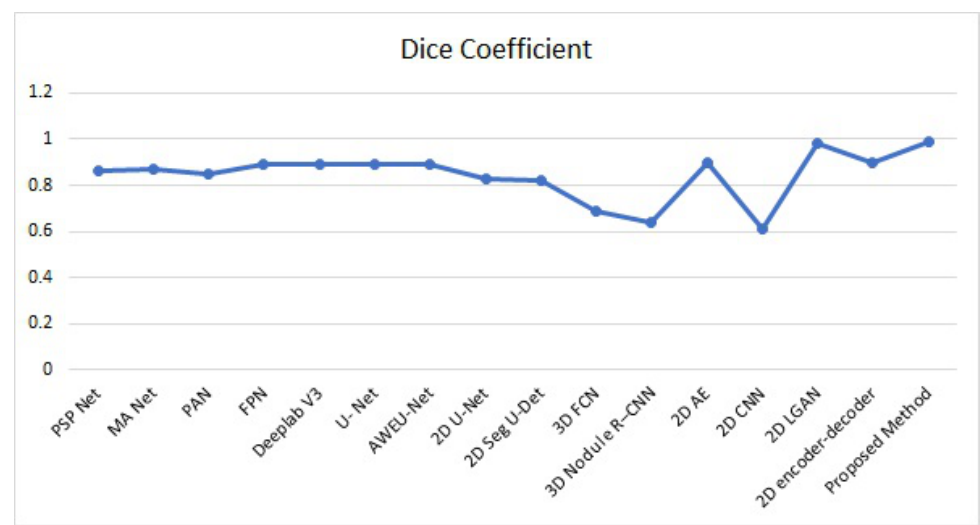
Figure 9. Dice coefficient comparison of existing methods with the proposed